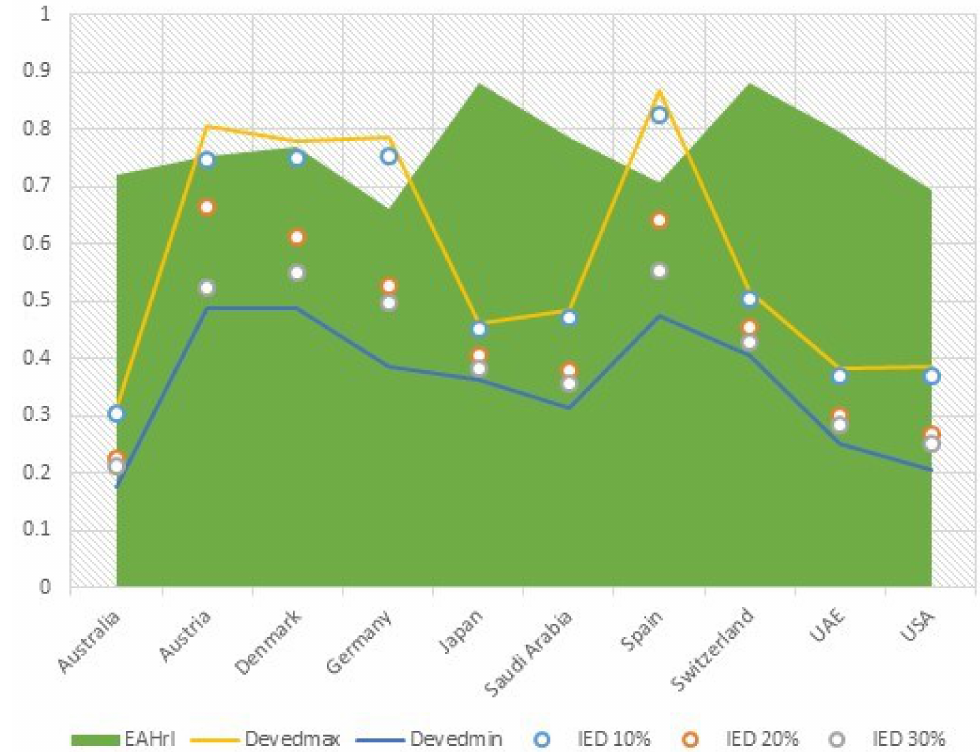
Figure 4. Forecast indicators of the impact of households’ increasing energy autonomy on the level of energy dependence of the studied developed countries until 2030. Source: generated by the